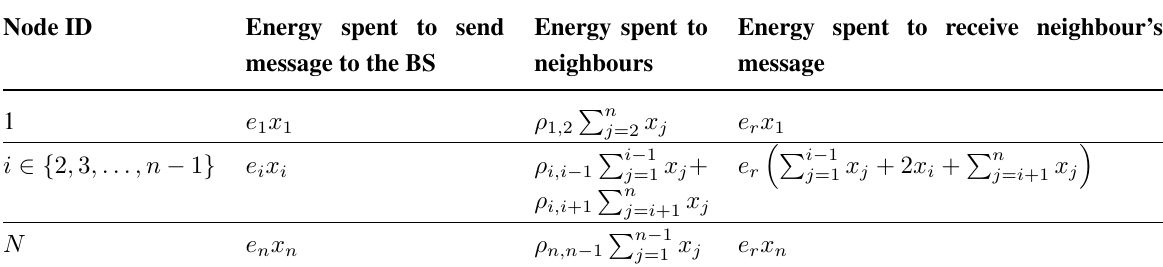
Table 1. Energy consumption by different nodes while acting as a